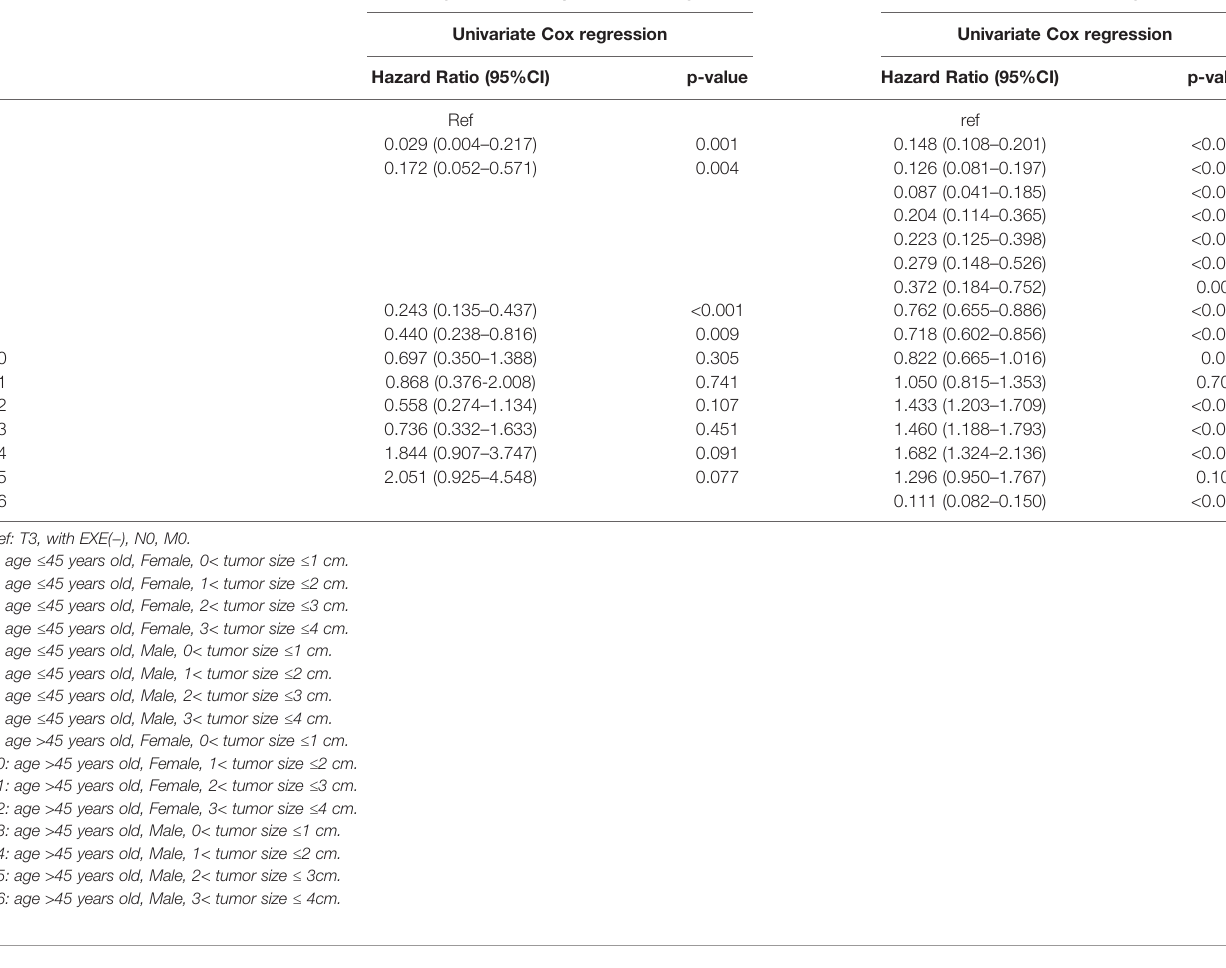
TABLE 6 | Analysis of SI-DTC and T3 (ETE − , N0, M0) subgroup. Covariate